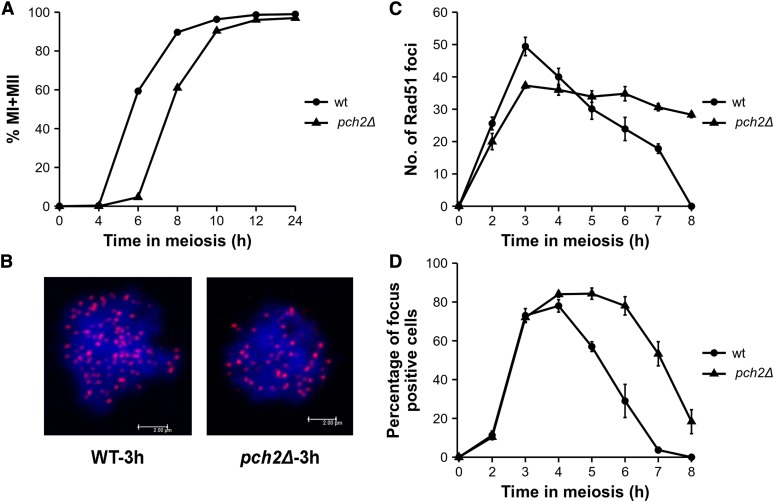
Rad51 foci analysis in wild type and pch2Δ mutants. (A) Meiotic time course assay for wild type and pch2Δ. Data are averaged across three independent meiotic time courses. (B) Representative image of Rad51 foci in wild type and pch2Δ at the 3 hr time point. (C) Average Rad51 foci counts with SE from three independent experiments in wild type and pch2Δ. Rad51 foci from 100 images were counted for each time point and each experiment. (D) Percentage of cells in a field that are positive for Rad51 foci at each time point. Cells with >5 Rad51 foci are counted as positive for Rad51 foci. Data are averaged across three independent experiments and plotted with SE measurements.